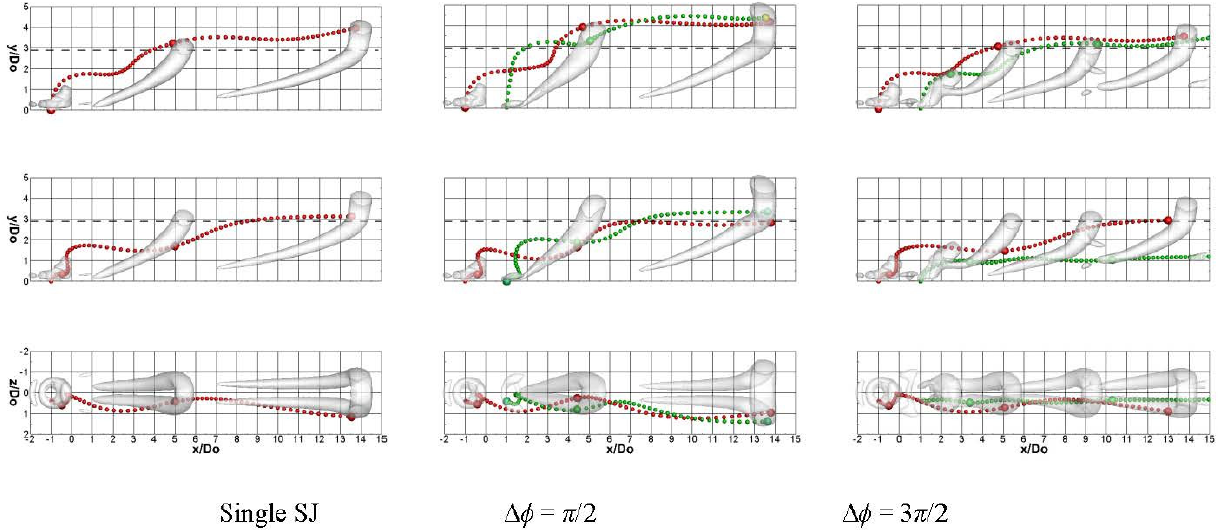
Figure 9. Tracking of particles that are released from different positions of the actuator orifices, top row: at center, middle & buttom rows: at z / D o = 0.4 (side and plan views)). Vortex structures are also added at t / T = 0.25 indicated by the particles with larger diameters.